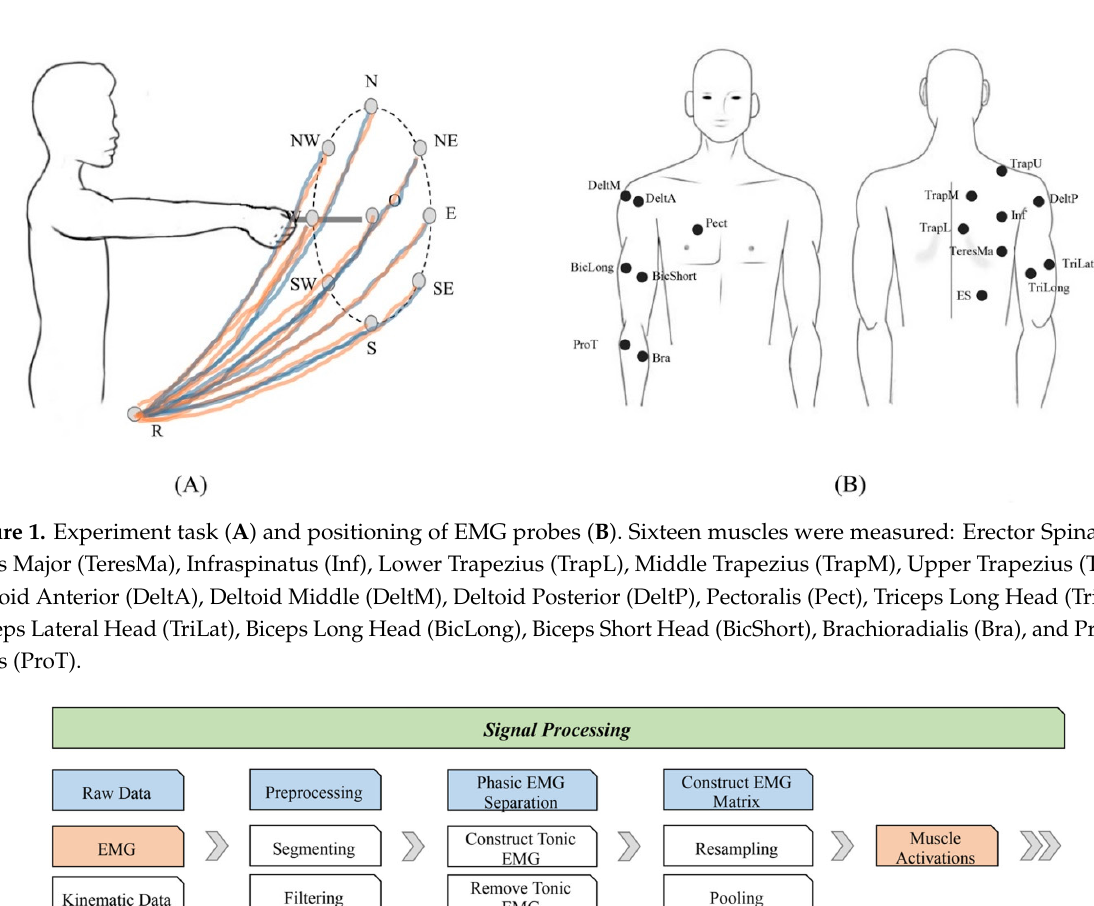
Figure 2. Data analysis flowchart.